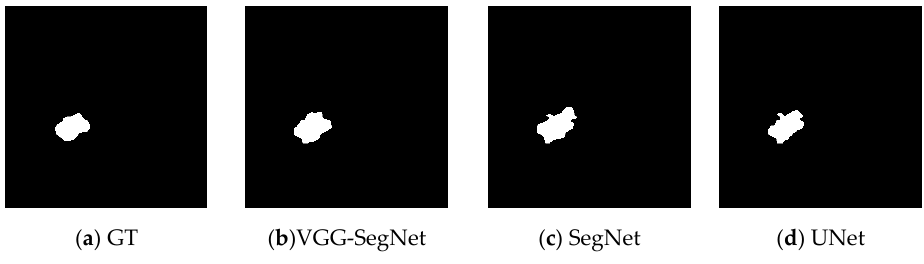
Figure 5. Segmentation results attained with considered CNN models. Table 3. Performance evaluation of CNN models on sample lung CT image. Best values are shown in bold.